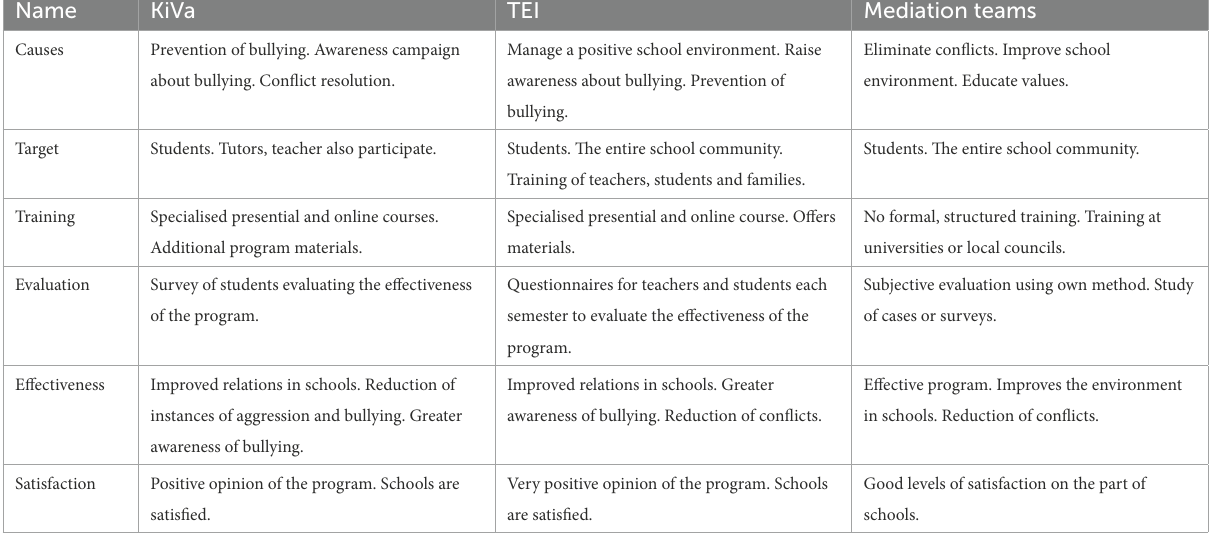
TABLE 3 Results of the KiVa, TEI and mediation teams programs. Name